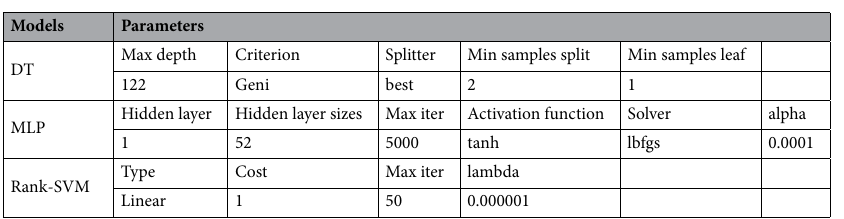
Table 4. Super parameter settings for the T-shaped angle-joint ventilation network multifault location diagnosis model.